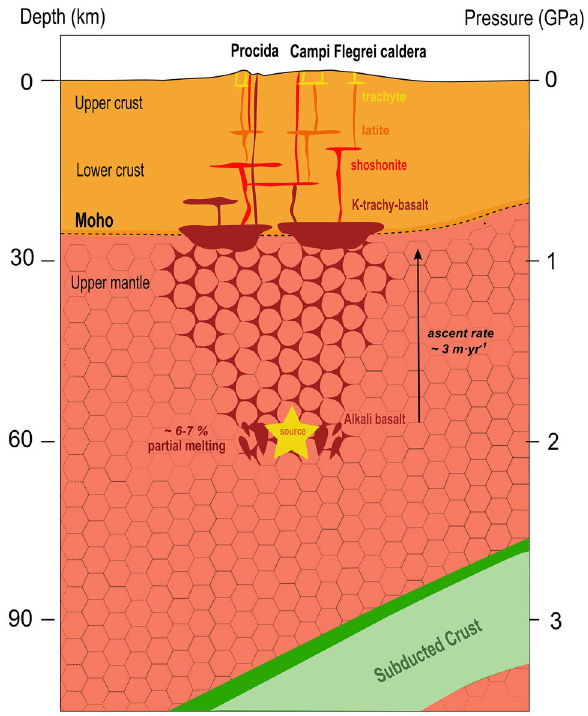
Figure 5. Cartoon summarizing the depth at which APR16 melt form 66 (yellow star), its migration path (red stripes) and evolution in terms of chemistry and rheology within a subduction geodynamic setting. CFVD plumbing system from the Moho level towards the surface has been modified after Fedi et al . 58